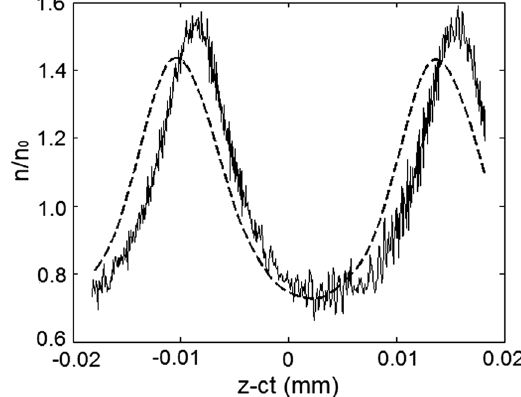
8. Measurement result of longitudinal average electric field with probe wavelength of 1600 nm after traveling 1.4 mm. The measurement result (dashed line) is shifted backward by 1 . 6 μ m relative to the actual value (solid